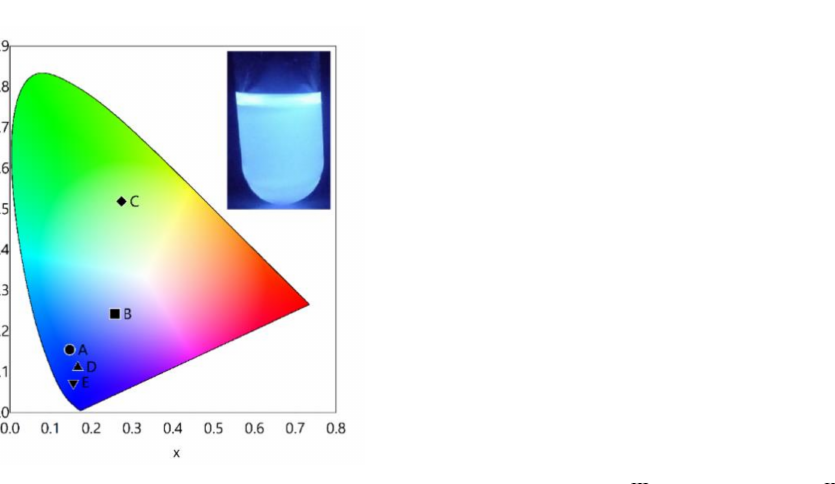
Figure 5. CIE coordinate diagram of ( A ) BimOEt 3 and its ( B ) Eu III complex, ( C ) Tb III complex, ( D ) Ce III complex at 280 nm excitation, and ( E ) Ce III complex at 377 nm excitation. The insert shows the intense bluish-white emission of the Eu III -BimOEt 3 complex in ethanol under 365-nm UV irradiation.